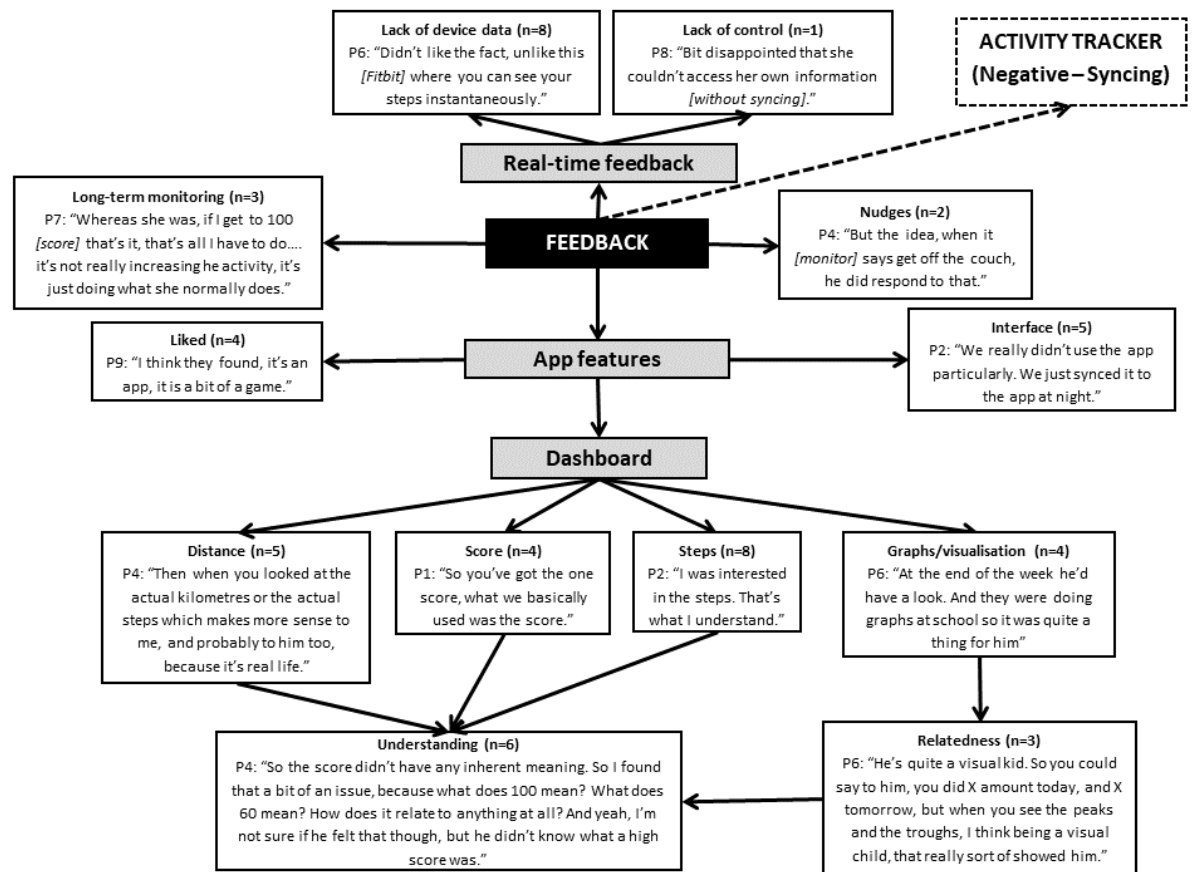
Figure 5. Parents’ perspectives on feedback provided by the wearable activity tracker and how this was used by them and their children. The